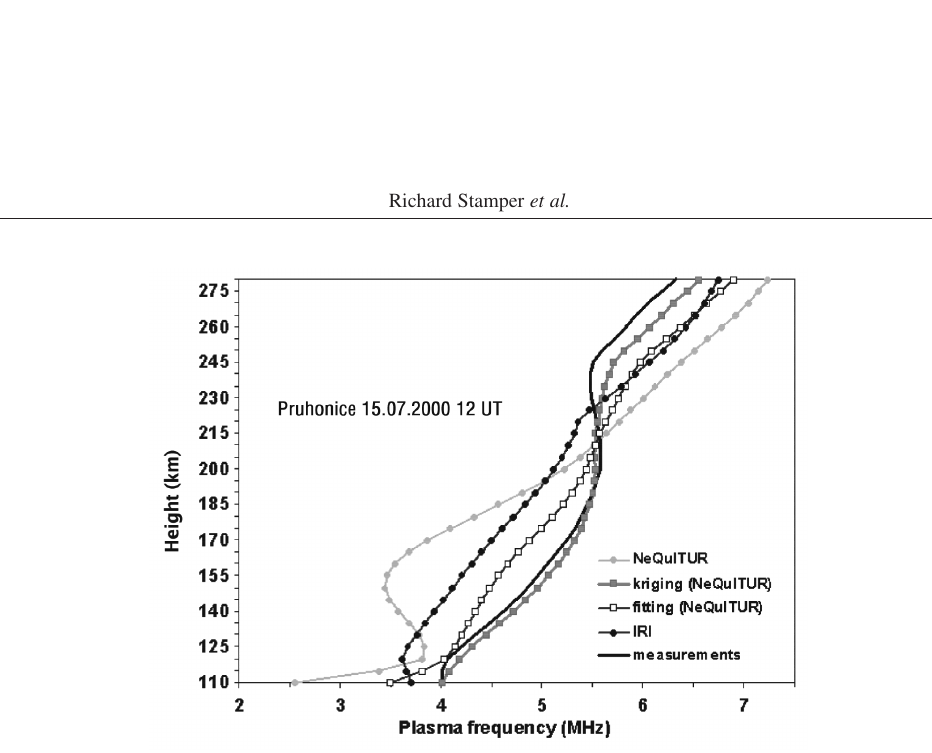
Fig. 3.11. Example of plasma frequency (electron density) height profiles at Pruhonice for 12 UT on 15 July 2000. The plot shows the profile inverted from the ionogram (solid line), and the profiles reconstructed by the IRI model, the NeQuITUR model, and the kriging and fitting adaptations of the NeQuITUR